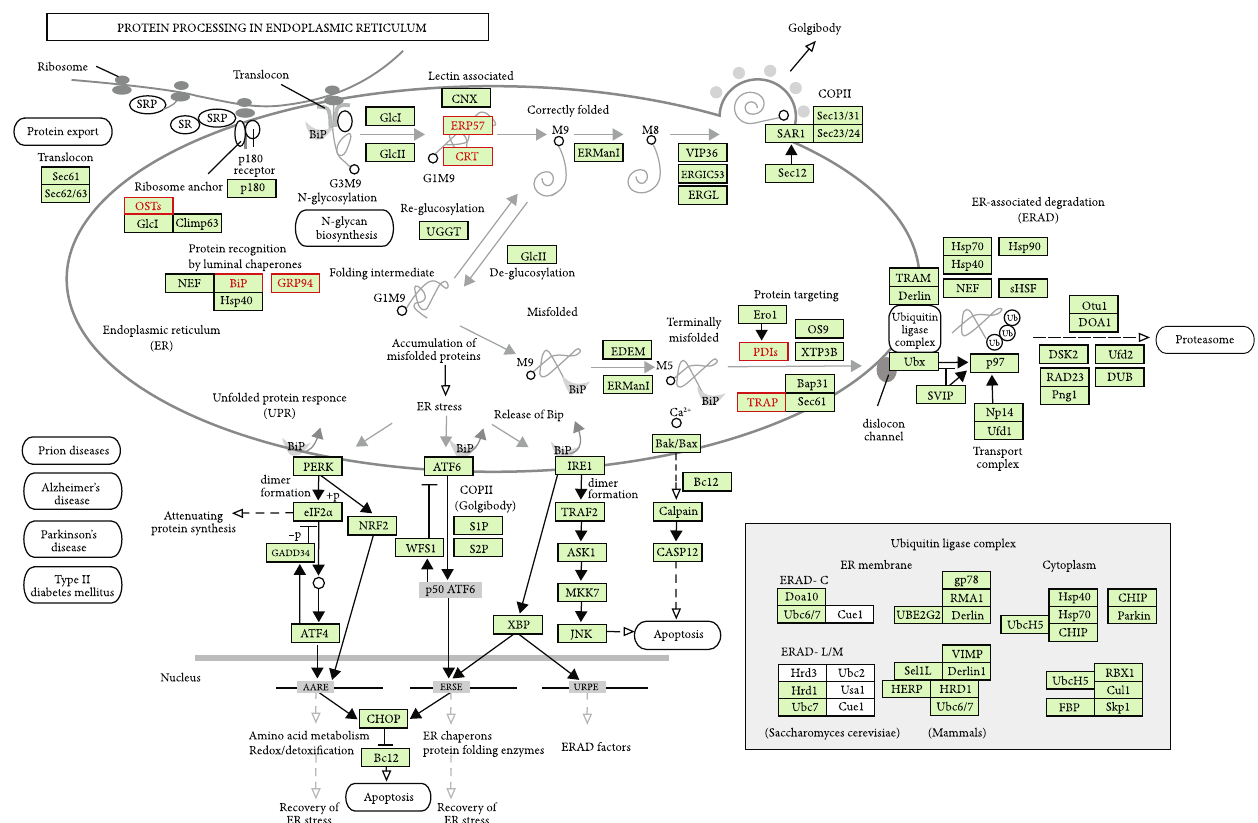
Figure 11: KEGG pathway of PDIA3 di ff erentially co-expressed